Question: Does the plotted quantity increase or decrease?
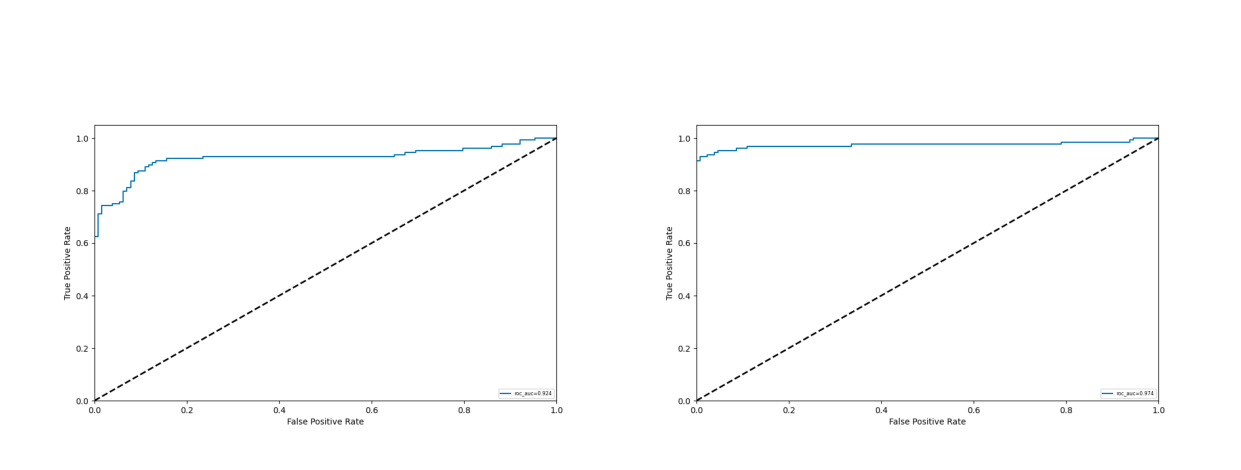
Answer: increasing